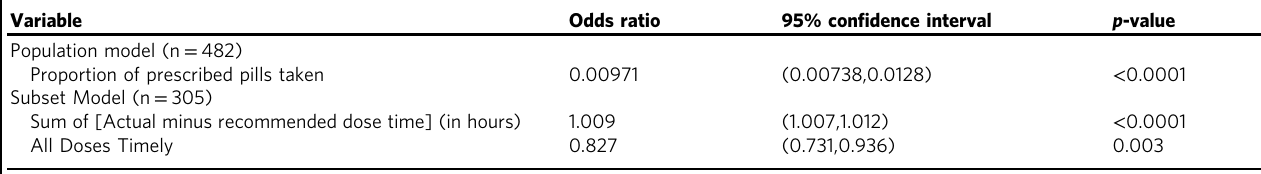
Table 2 Regression analysis of model results